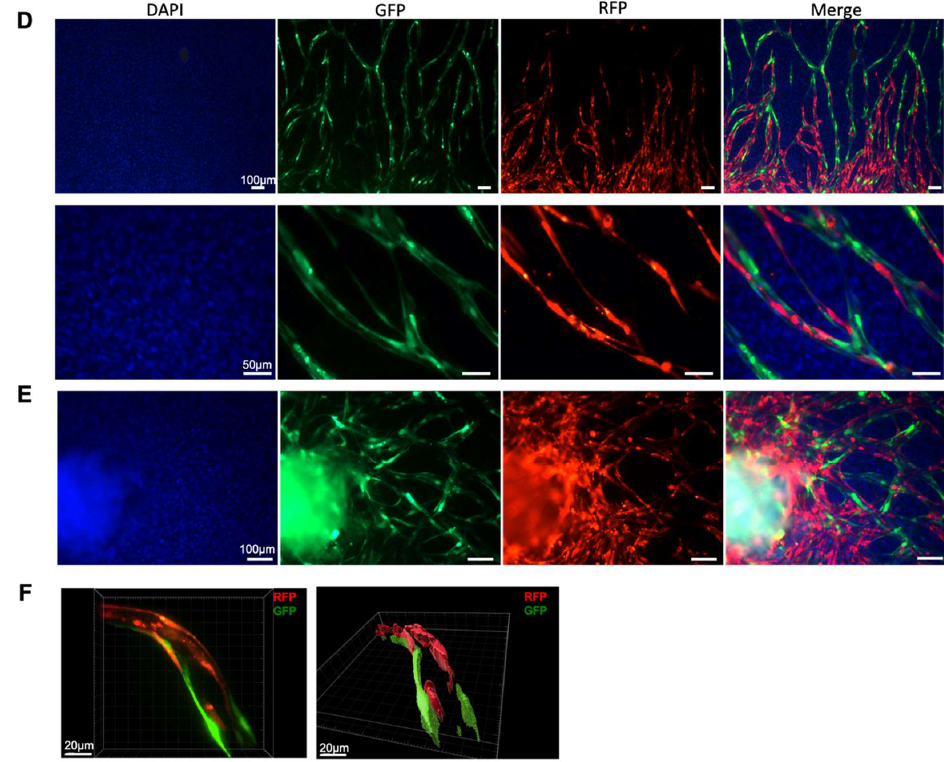
Figure 5. Vascular network connection between the vascularized microenvironment and vascular- ized PDT. Immunofluorescence analyses showing ( A ) Experimental scheme for the combination of vascularized PDTs and vascularized fibrin gel. ( B ) the global vascular network connecting PDTs and the fibrin gel; ( C ) the global vascular network surrounding one PDT; ( D , E ) the connection of two different original vascular networks in the fibrin gel ( D ) and inside the PDO ( E ); ( F ) 3D-reconstruction of one vessel developed by both GFP- and RFP-labeled endothelial cells.